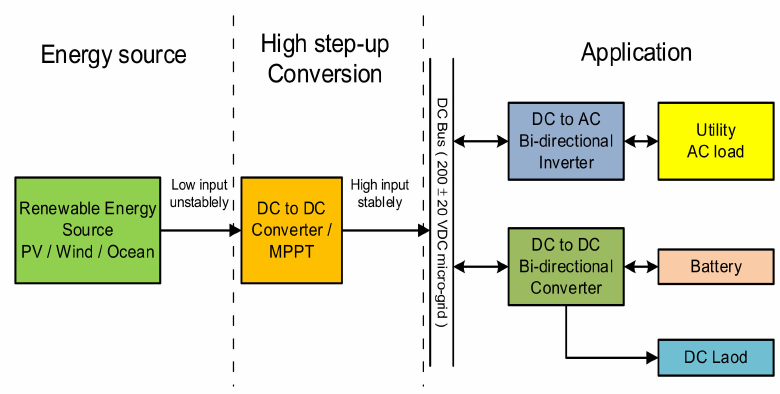
Figure 1. Application block diagram of green energy